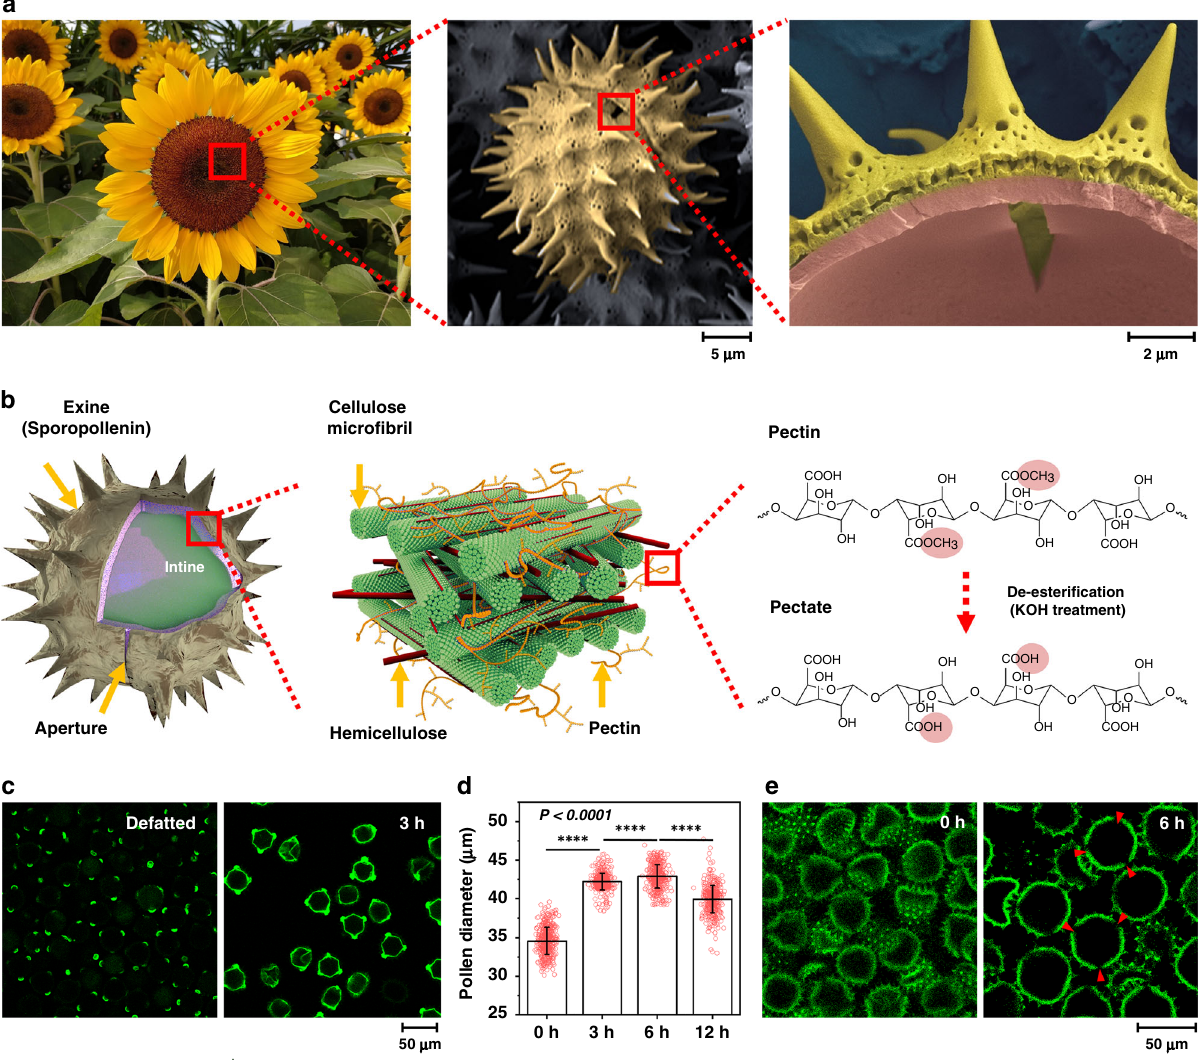
Fig. 1 Engineering dynamic responsiveness in pollen particles. a Steps involved in the extraction of pollen grains from sun fl ower plants, shown here with cross-sectional SEM images. The pollen structures are pseudo-colored. b Schematic illustration of stimuli-responsive pollen capsule behavior at multiple length scales. Left: Pollen structural components. Middle: Cellulose micro fi brils organized by hemicellulose and pectin in the intine layer. Right: Hydrolytic conversion of pectin to pectate within the intine layer. c Immuno fl uorescence microscopy detection of de-esteri fi ed pectin within pollen shells using JIM5 as the primary antibody. d Size characterization of treated pollen particles as a function of KOH incubation time, as measured by DIPA. Data are analyzed by Student ’ s t -test and are presented as mean ± s.d. ( n = 500 per condition). **** p < 0.0001. Source data are provided as a Source Data fi le. e Cross- sectional CLSM images of pollen-derived microgel particles. Red arrows indicate aperture